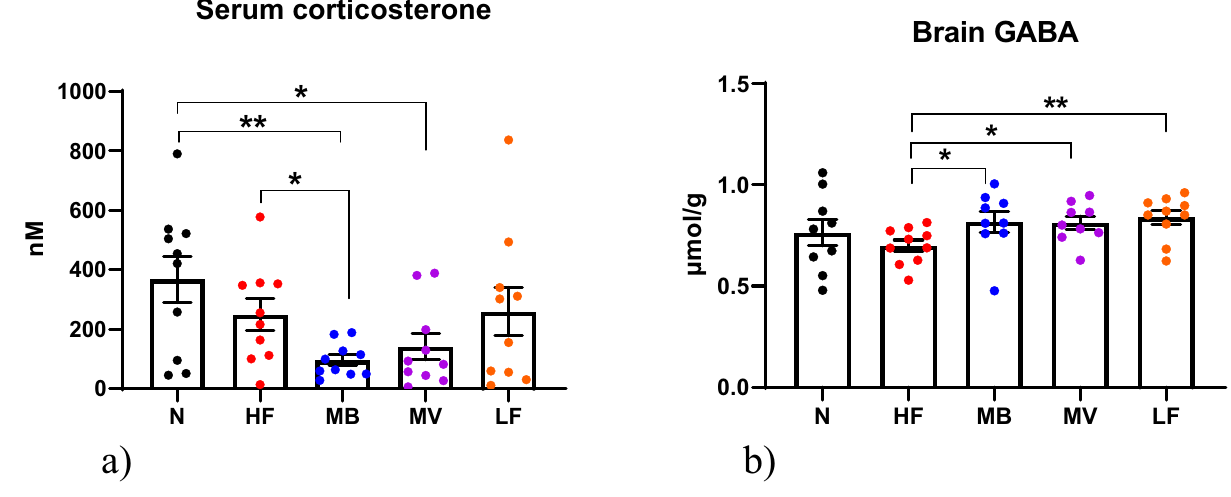
Figure 2. Blood and brain markers. ( a ) Serum corticosterone (nM) and ( b ) brain gamma-aminobutyric acid (GABA, µmol/g) in conventional rats (N) fed a high-fat diet or in ApoE-/- rats fed either a low-fat diet (LF), or a high-fat diet as it is (HF) or supplemented with 1% monobutyrin (MB) or monovalerin (MV). Data are shown as means and their standard errors. Significant differences compared with the HF group: *, p < 0.05; ** p <